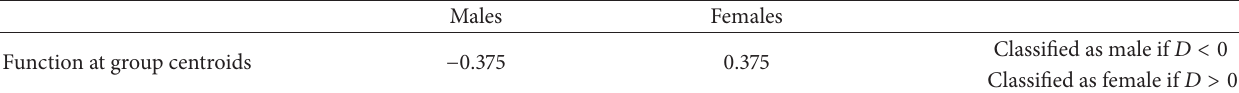
Table 2: Calculation of the discriminant equation and discriminant score ( 𝐷 ).